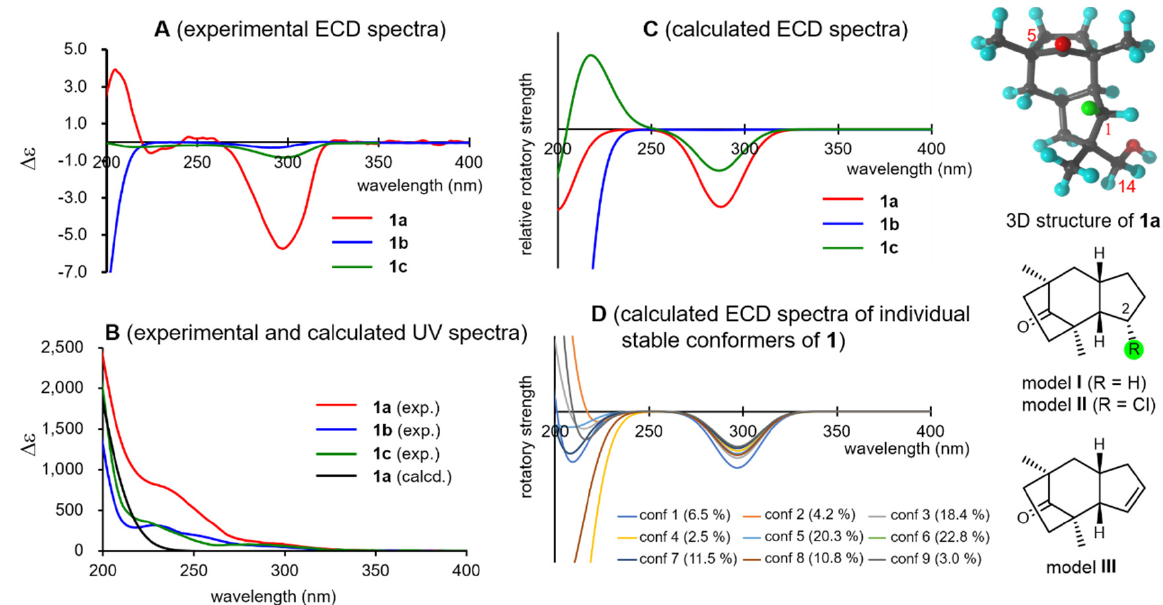
Figure 3. Experimental UV/ECD spectra of 1a , 1b , and 1c (spectra A and B ), calculated ECD spectra (spectra C ), calculated ECD spectra of the individual conformers of 1a (spectra D ), three-dimensional structure of 1a , and structures of models I – III .